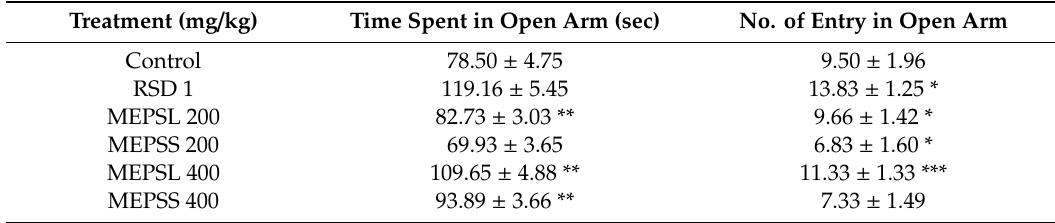
Table 1. Anxiolytic e ff ects of MEPSL, MEPSS, and diazepam on behavior of mice in elevated plus-maze model test in mice.